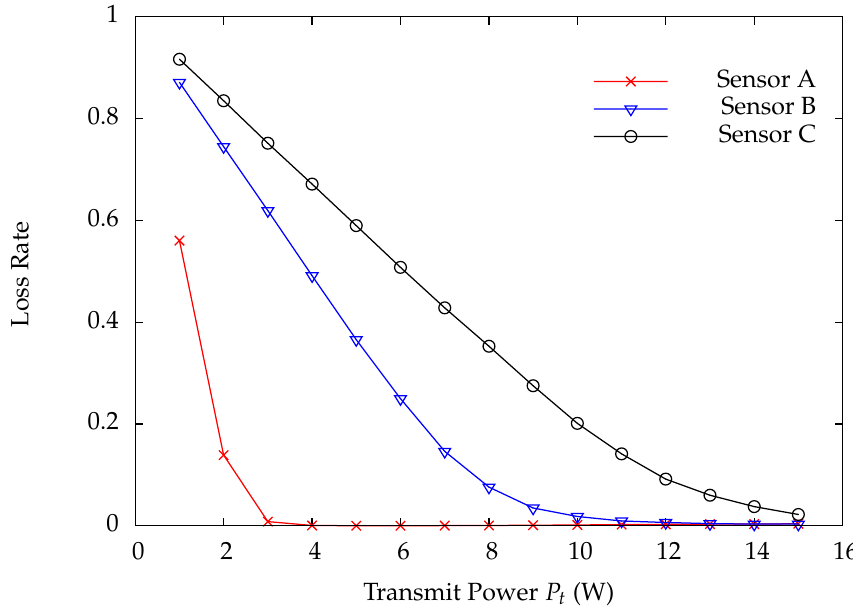
Figure 13. Loss rate versus transmit power P t .